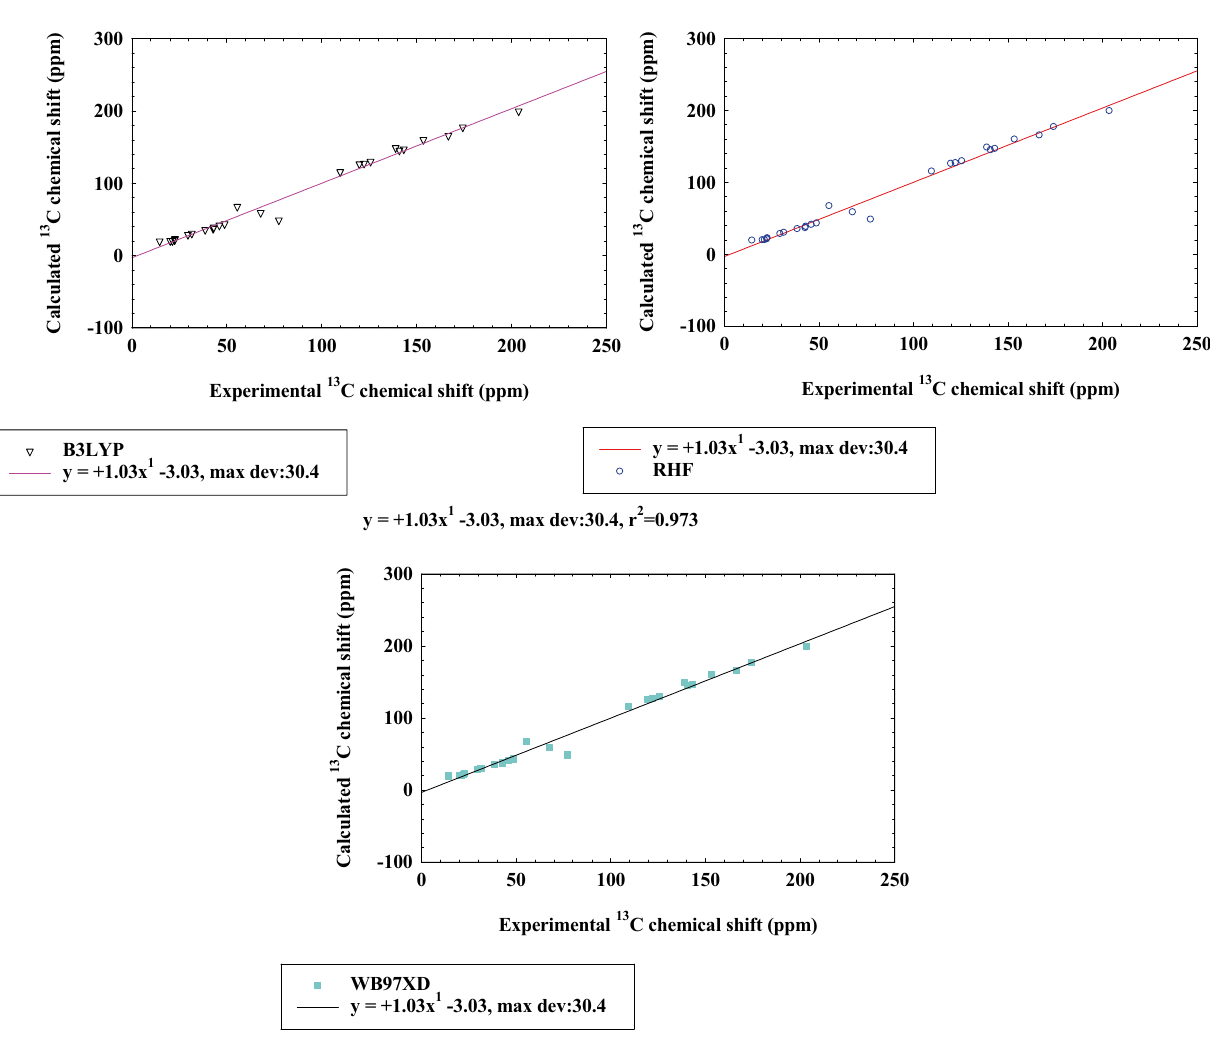
Fig. 8 Comparison of experimental [9] and theoretical 13 C chemical shifts of andirobin calculated at the RHF, B3LYP and wB97XD levels with 6–311 G(d,p) basis